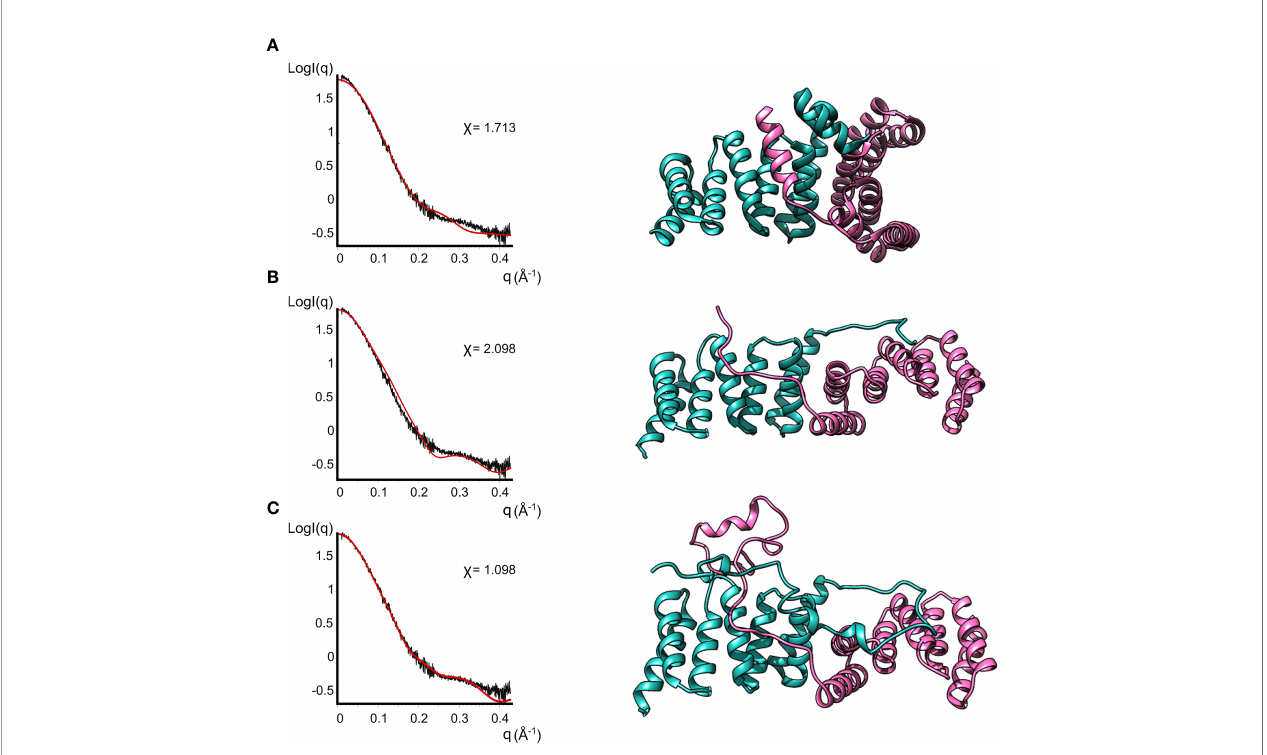
FIGURE 4 | Models of IpgC dimers (right panels) and the corresponding fi ts to solution SAXS data (left panels). Model (A) is the asymmetric IpgC dimer (PDB ID: 3GZ1). Model (B) is the symmetric IpgC dimer (PDB ID: 3KS2). Model (C) is the symmetric IpgC dimer where the residues not present in the crystal structure were modeled to be compatible with the SAXS